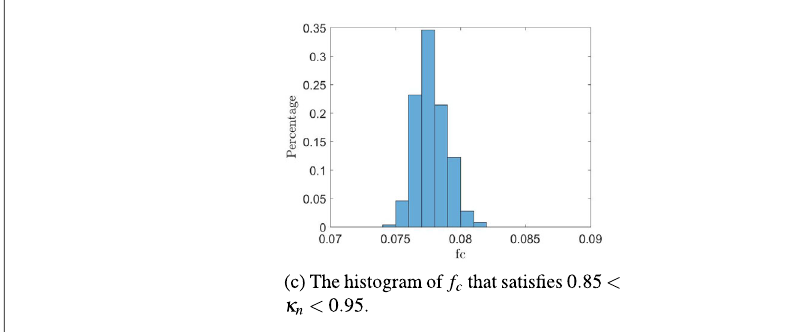
Figure 3 The histograms of the fraction of closed channels f c for the rectangular